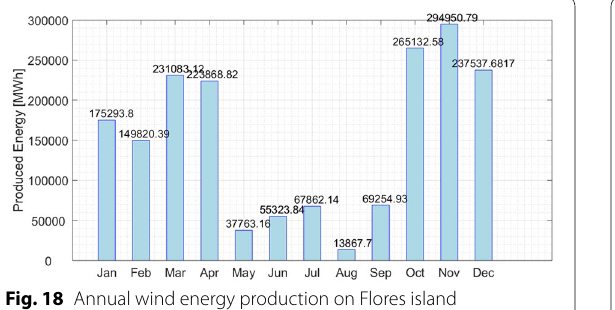
Fig. 19 Estimated total renewable energy emission and monthly consumption for 2018 in Flores